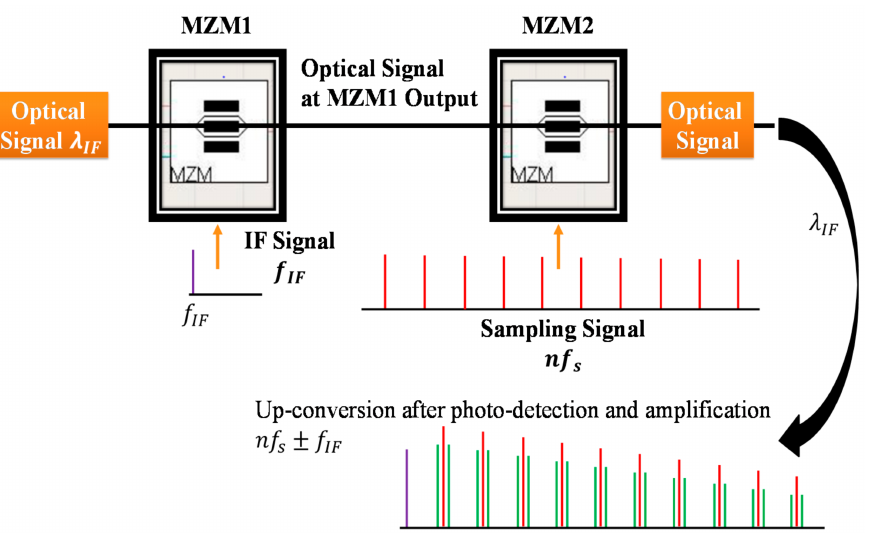
Figure 2. Principle of frequency up-conversion technique based on a cascaded MZMs link by using a sampling